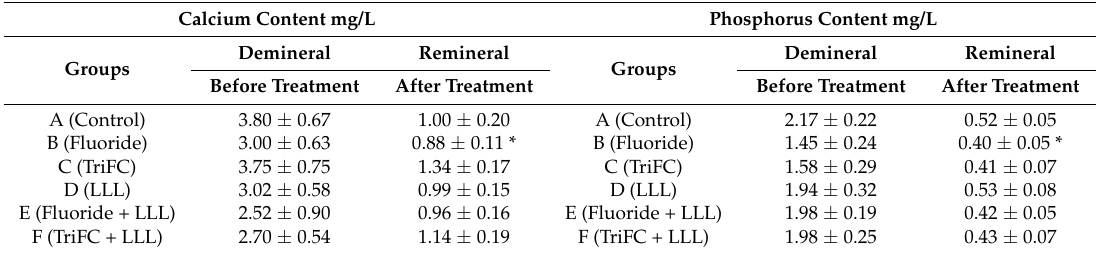
Table 1. Solutions analysis of calcium and phosphorus content during treatment.